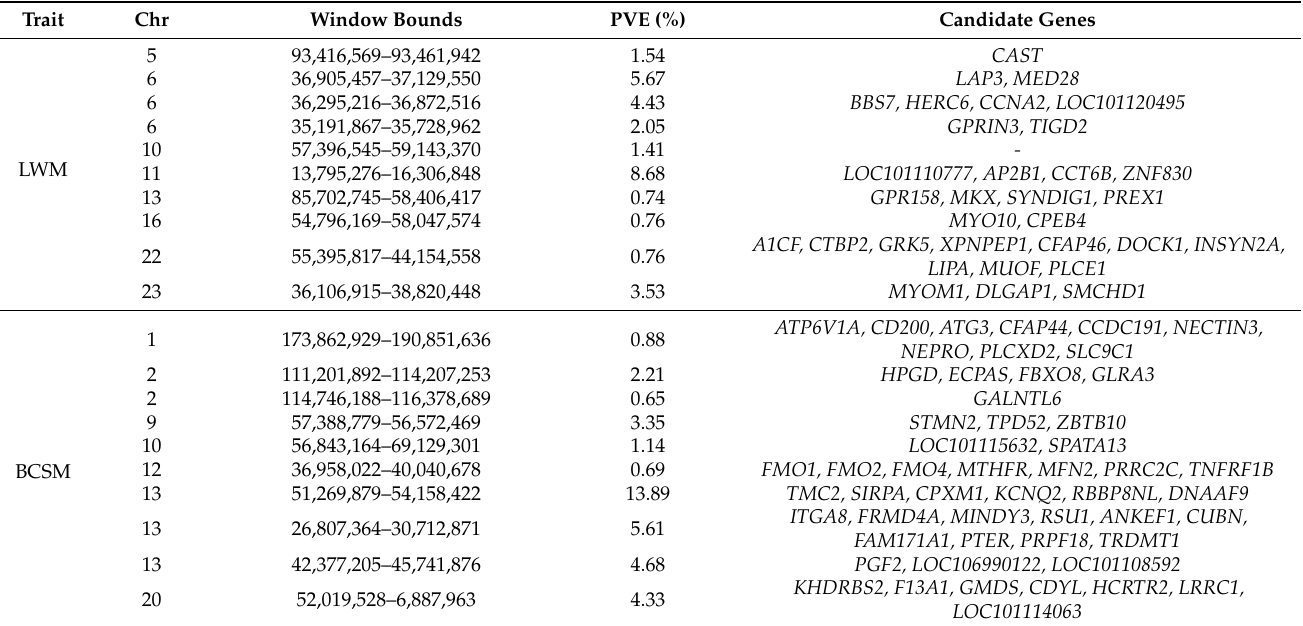
Table 3. Chromosome, location, proportion of additive genetic variance (PVE, %) and candidate genes within the top 10 windows associated with the live weight (LWM) and body condition score (BCSM) at mating of Merino